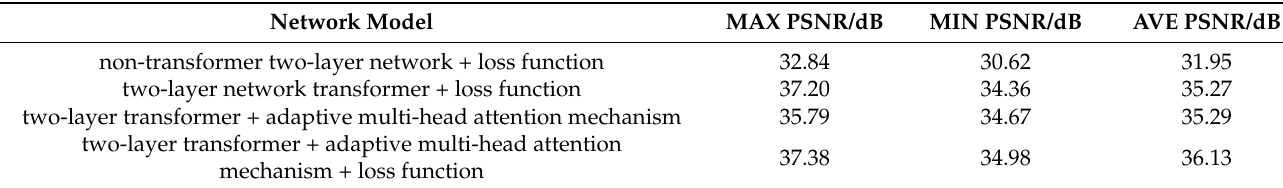
Table 3. Comparison of PSNR metric for ablation experiments.